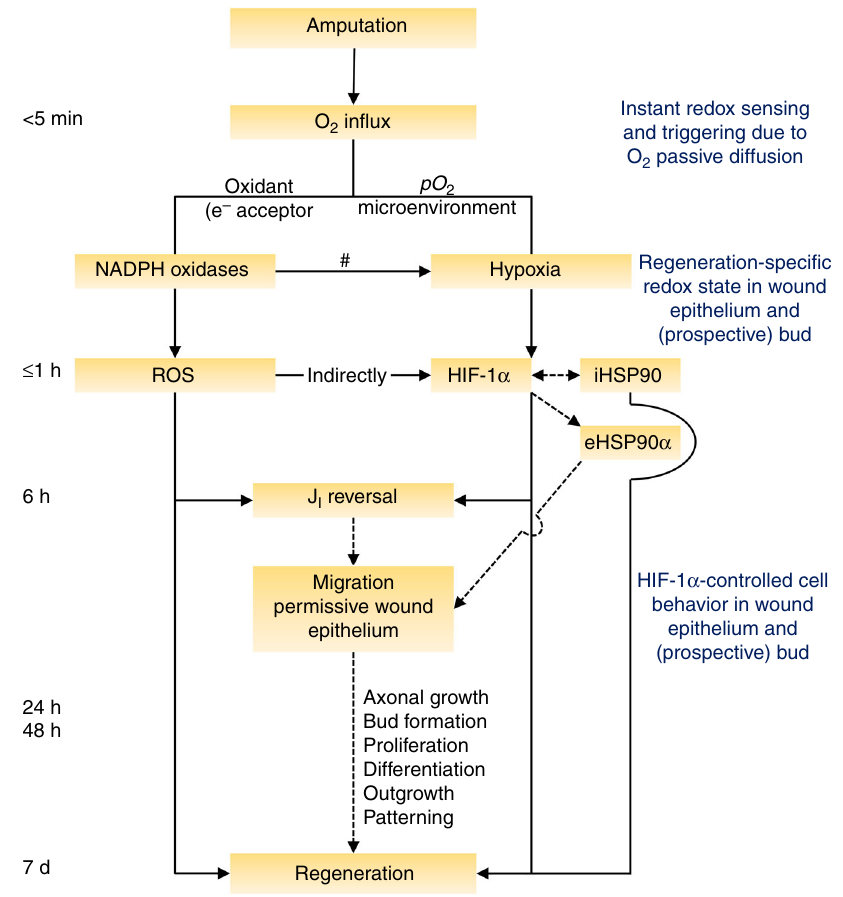
Fig. 8 Stepwise model integrating redox state activities during regeneration. Instantaneous injury-induced O 2 in fl ux fuels ROS production and together tune a permissive pO 2 microenvironment — hypoxia — for HIF-1 α stabilization. Early time-window up to 6 hpa is focused, because is when the magnitude of O 2 in fl ux correlates with regeneration and when required ROS and HIF-1 α activities occur. ROS per se do not feedback with the magnitude of O 2 in fl ux. ROS